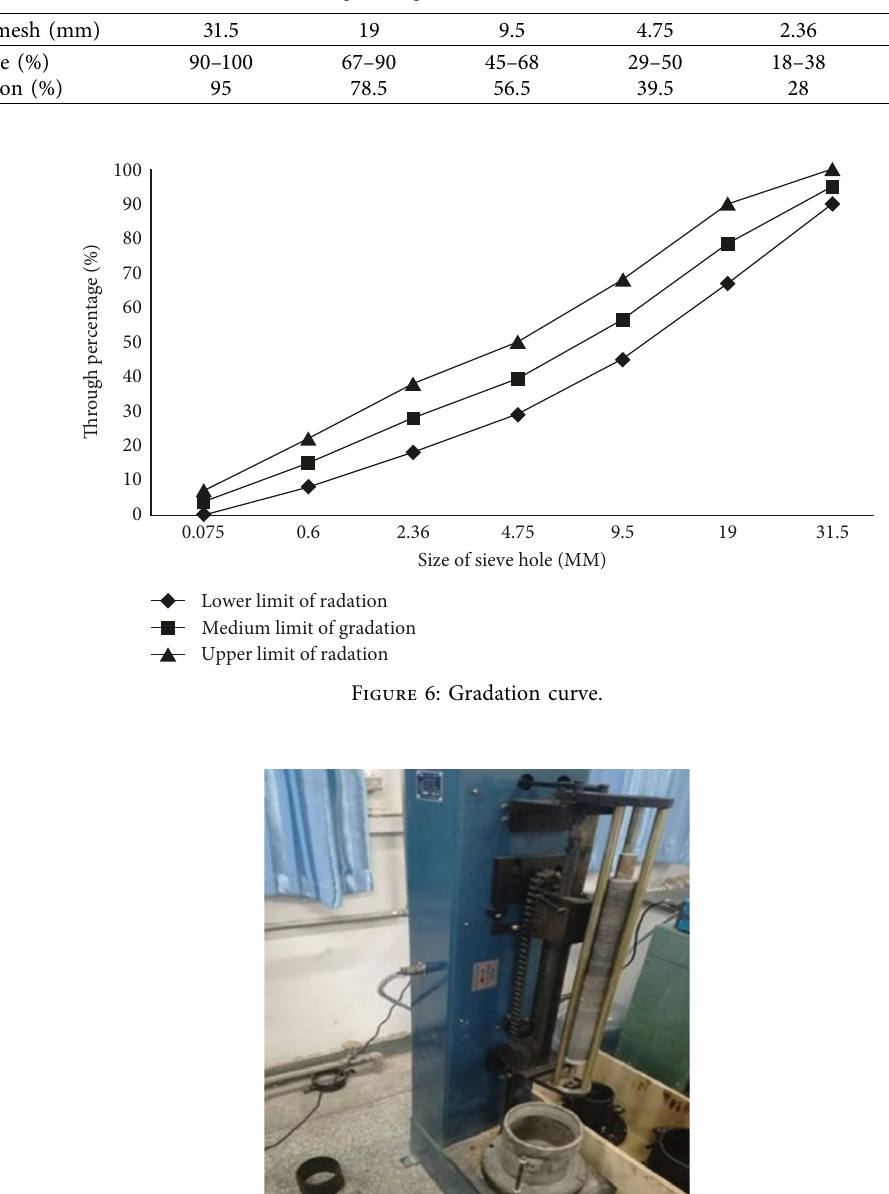
Table 4: Recommended ranges for grain size fractions of cement stabilized materials.